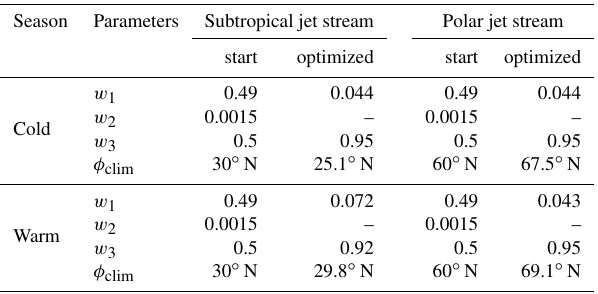
Table 1. Start and optimized jet stream parameters used for the edge cost